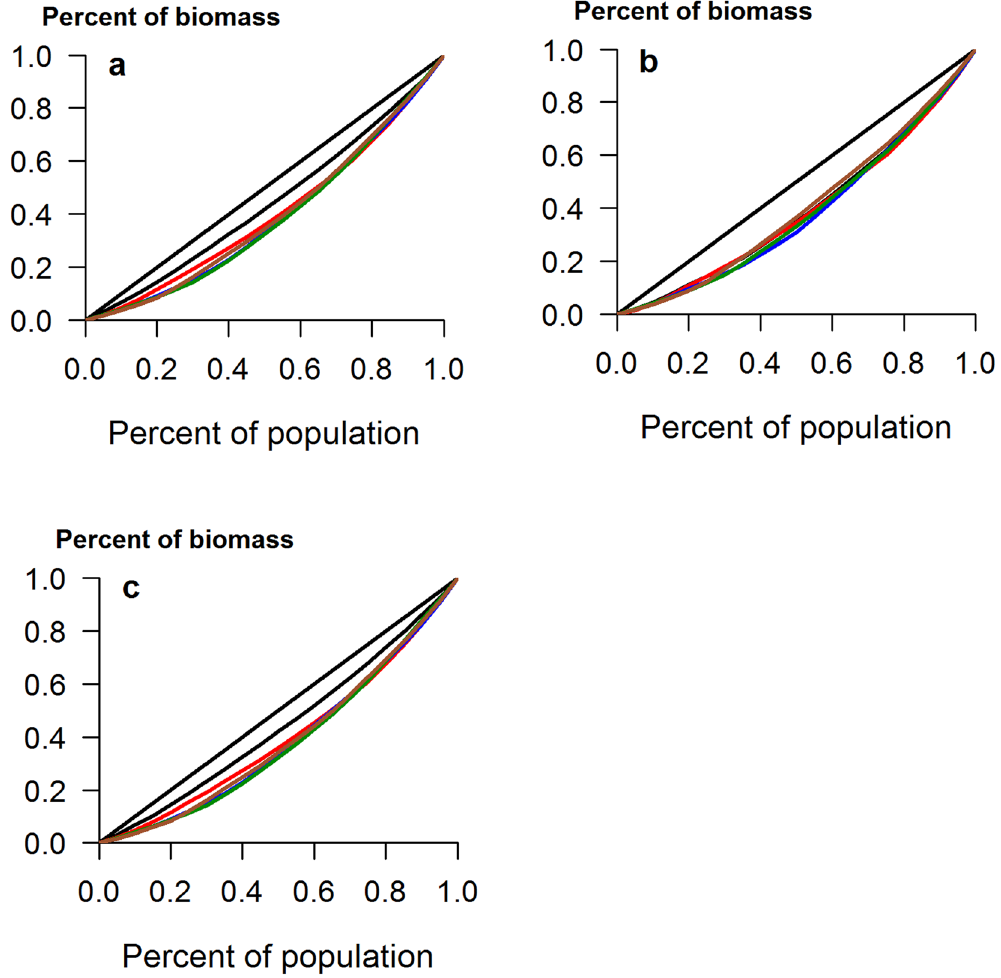
Figure 6. Lorenz curves for ( a ) total biomass, ( b ) root biomass and ( c ) shoot biomass of calabrese plants grown in Indian field soil. Legend as in Fig.